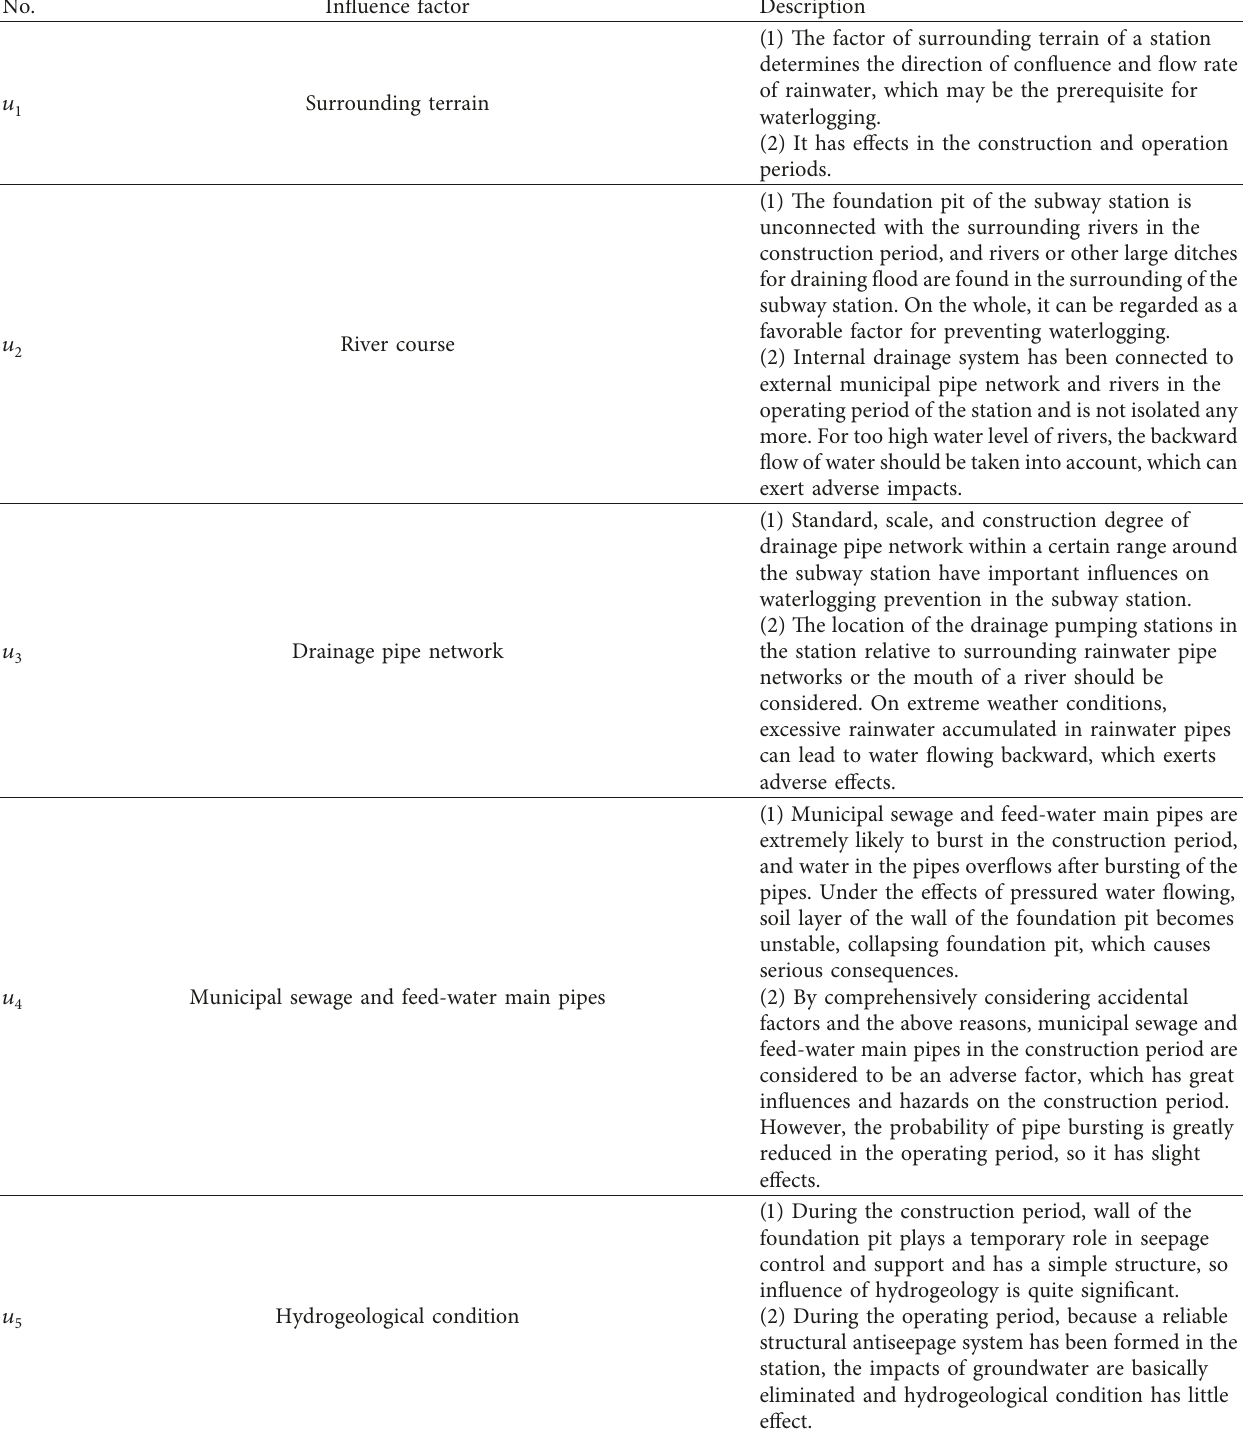
Table 1: List of influence factors for evaluation of waterlogging risk in the urban subway station.